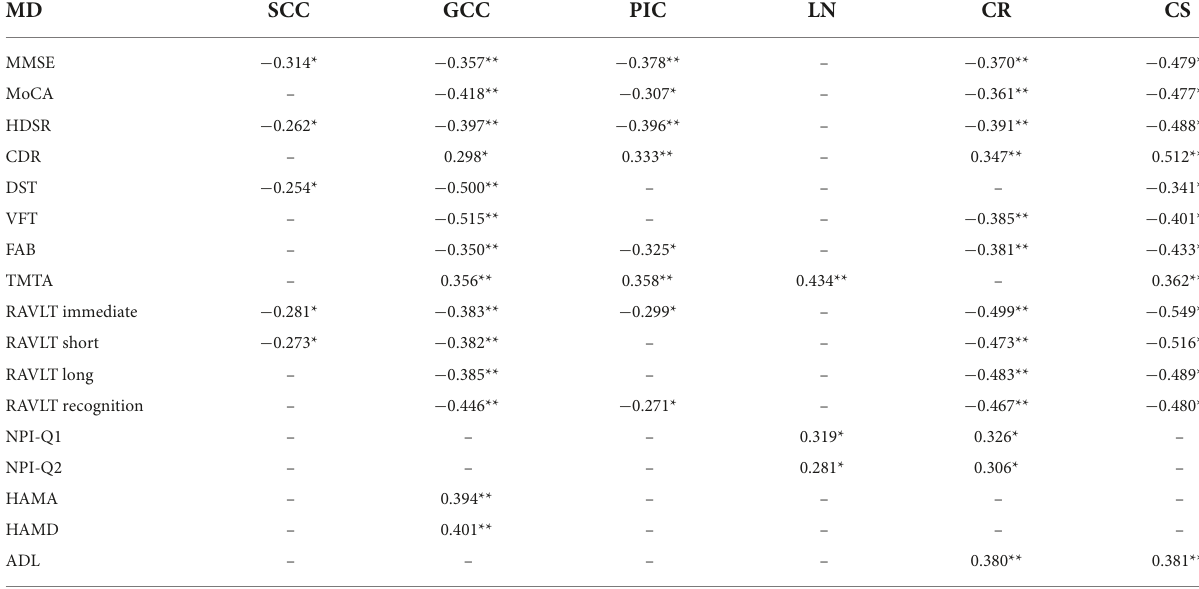
TABLE 7 Pearson’s correlation analysis between MD and neuropsychological